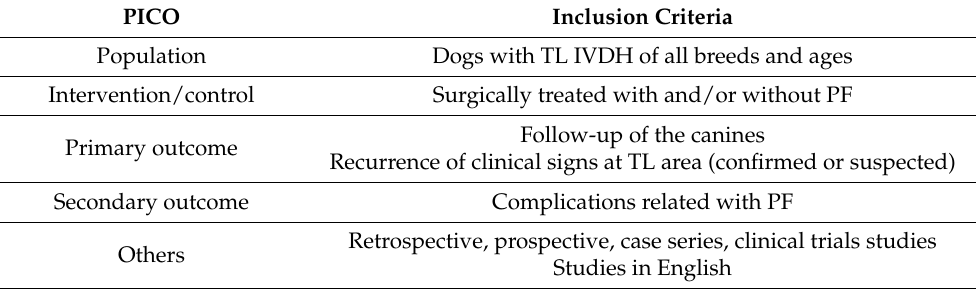
Table 1. PICO. PICO Inclusion Criteria Population Dogs with TL IVDH of all breeds and ages Intervention/control Surgically treated with and/or without PF Follow-up of the canines Primary outcome Recurrence of clinical signs at TL area (confirmed or suspected) Secondary outcome Complications related with PF Retrospective, prospective, case series, clinical trials studies Others Studies in